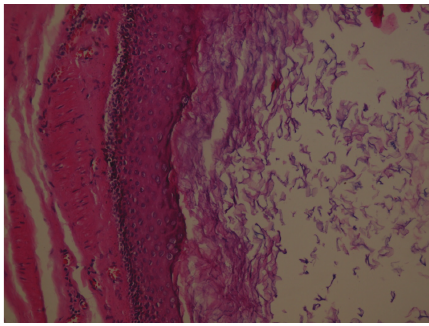
Figure 4: The microscopic image of epidermoid cyst lined with stratified squamous epithelium containing laminated keratinous